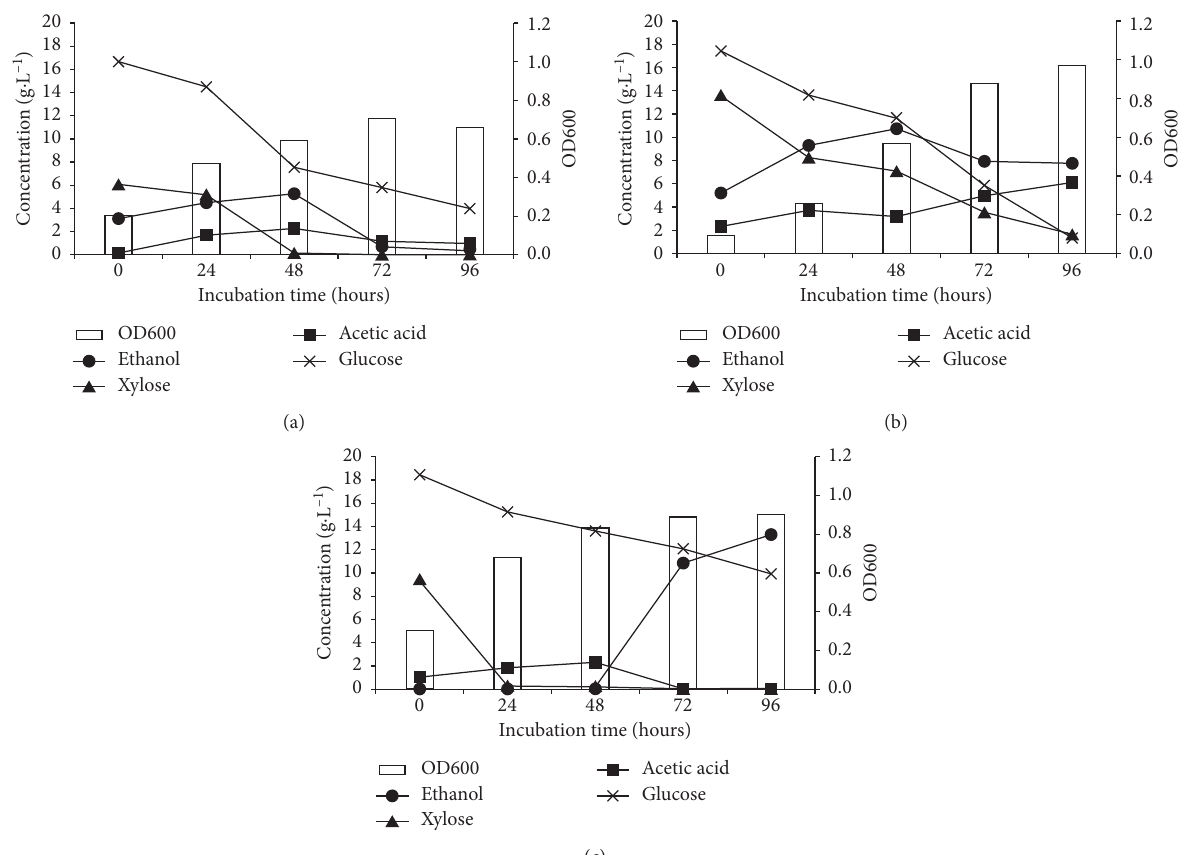
Figure 8: The effect of inoculum concentration: (a) 5%; (b) 10%; and (c) 20% (v/v) on bioethanol production.